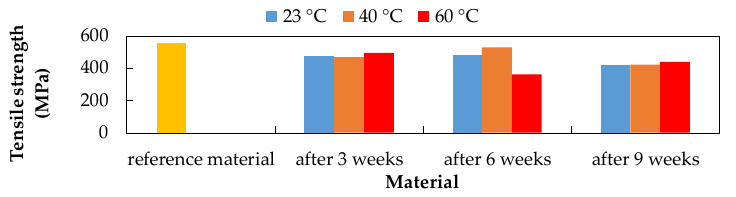
Material Figure 4. Influence of exposure to 20% NaCl at different temperatures on the CFRP composite. Figure 4. Influence of exposure to 20% NaCl at different temperatures on the CFRP composite. Figure 4. Influence of exposure to 20% NaCl at different temperatures on the CFRP composite. Figure 4. Influence of exposure to 20% NaCl at different temperatures on the CFRP composite. Due to the influence of the CFRP composite exposure to 10% NaOH (Figure 5), the Due to the influence of the CFRP composite exposure to 10% NaOH (Figure 5), the Due to the influence of the CFRP composite exposure to 10% NaOH (Figure 5), the Due to the influence of the CFRP composite exposure to 10% NaOH (Figure 5), the greatest decrease in tensile strength after six weeks at 60 °C and the smallest decrease in greatest decrease in tensile strength after six weeks at 60 ◦ C and the smallest decrease in greatest decrease in tensile strength after six weeks at 60 °C and the smallest decrease in greatest decrease in tensile strength after six weeks at 60 °C and the smallest decrease in tensile strength after six weeks at 40 °C were recorded. tensile strength after six weeks at 40 ◦ C were recorded. tensile strength after six weeks at 40 °C were recorded. tensile strength after six weeks at 40 °C were recorded.